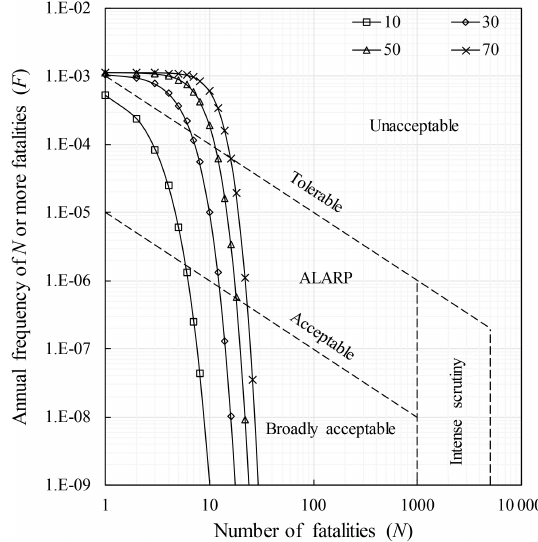
Figure 15. Impact of the density of vehicles on the annual societal risk. The numbers in the legend refer to the number of vehicles per